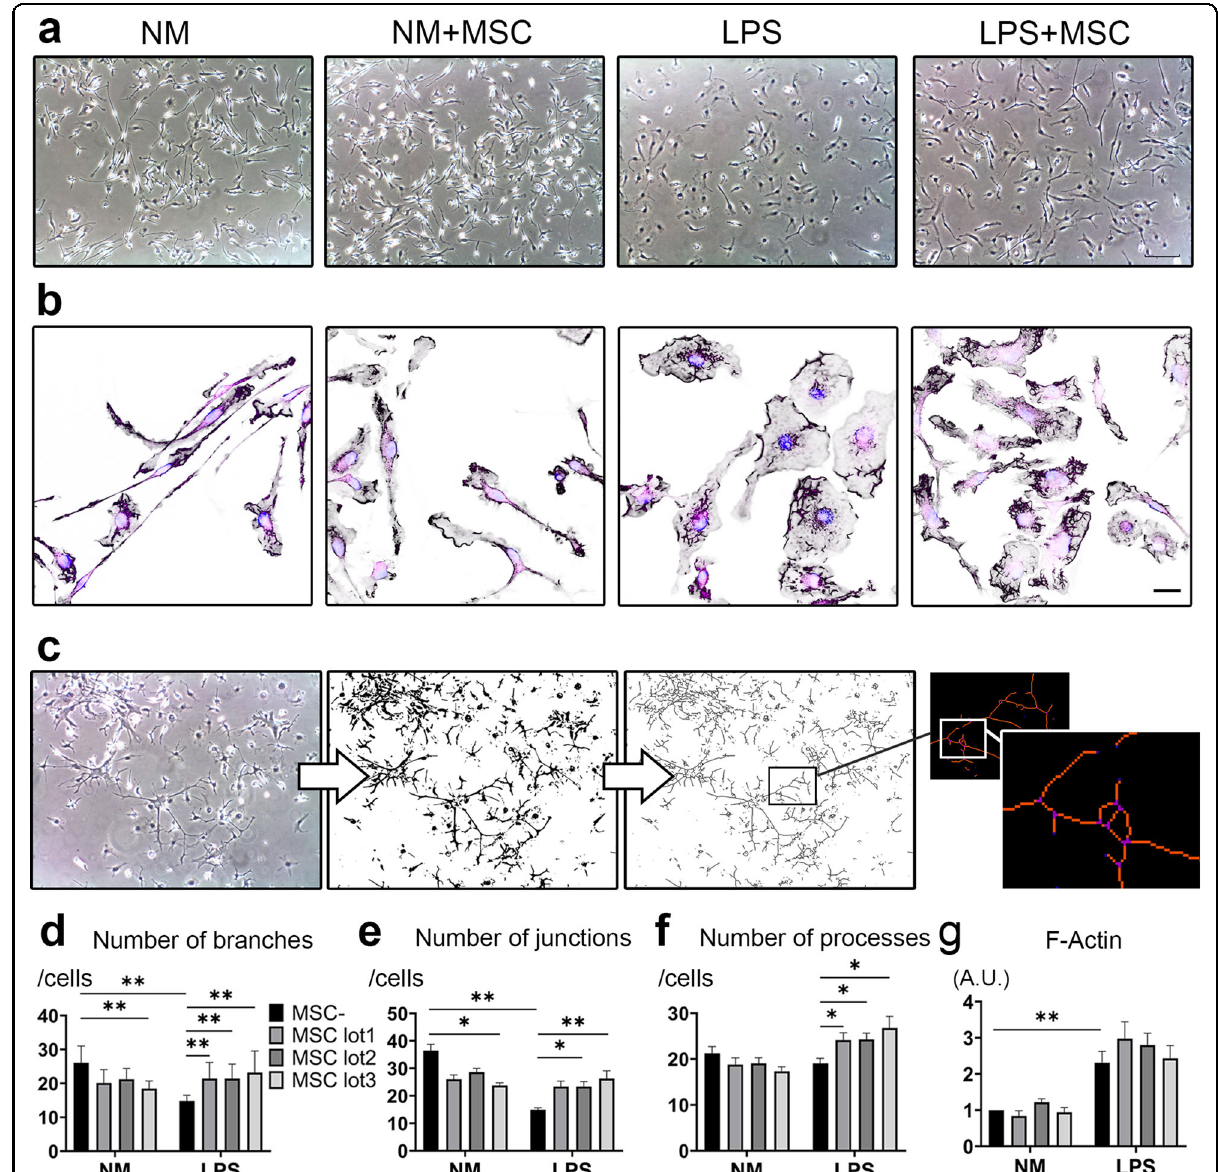
Fig. 3 Actin dynamics of LPS activated microglia change after co-culture with MSC. Phase contrast images of four groups (scale bar = 100 μ m) ( a ). Immunocytochemistry of F-Actin (black), vinculin (purple) and Hoechst 33342 (blue) (scale bar = 20 μ m) ( b ). For skeleton analysis, the images underwent background subtraction, binarized and skeletonized for quanti fi cation ( c ). Quanti fi cation on the number of branches ( d ), junctions ( e ), processes ( f ), and F-Actin ( g ). (Dunn ’ s multiple comparisons test was used). Data are presented as mean ± SEM with ** p < 0.01, * p < 0.05. Abbreviation: A.U., arbitrary